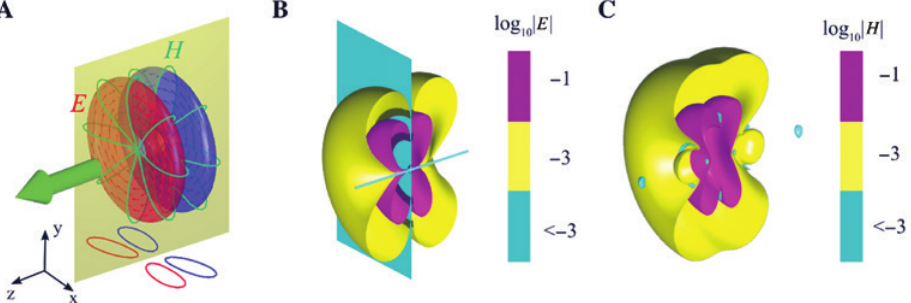
Figure 1: Large- and fine-scale topology of the single-cycle TE FD pulse. (A) Isosurface of the electric field consisting of two doughnut-shaped regions. Red and blue colors indicate the two half-cycles of the pulse, respectively. Green lines show the (radially and longitudinally oriented) magnetic field winding around the (azimuthally oriented) electric field, while red arrows mark the direction of the latter. The solid green arrow indicates the direction of pulse propagation along the positive z -axis. (B, C) Isosurface plots of the logarithm of the normalized electric (B) and magnetic (C) field modulus at different field values. Purple color marks the strong field central regions of the pulse presented in (A), while light blue indicates the location of the zeros of the fields. In order to reveal the complex field structure, only the half of the pulse that lies in the negative x -space is presented in (B) and (C). In all = 10 q panels, the pulse is considered at focus ( t = 0), while q 2 1